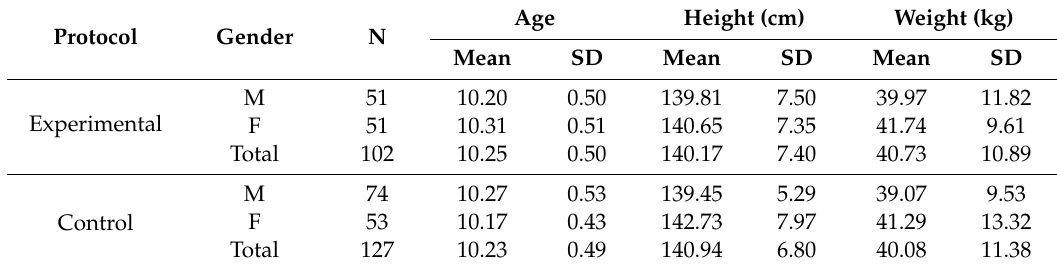
Table 1. Descriptive characteristics of the